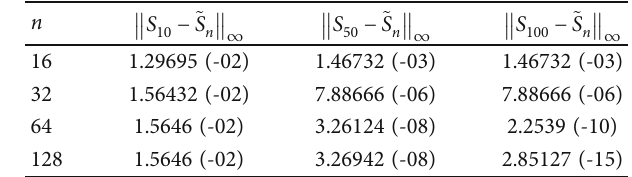
Table 2: Error norms between S ∗ n